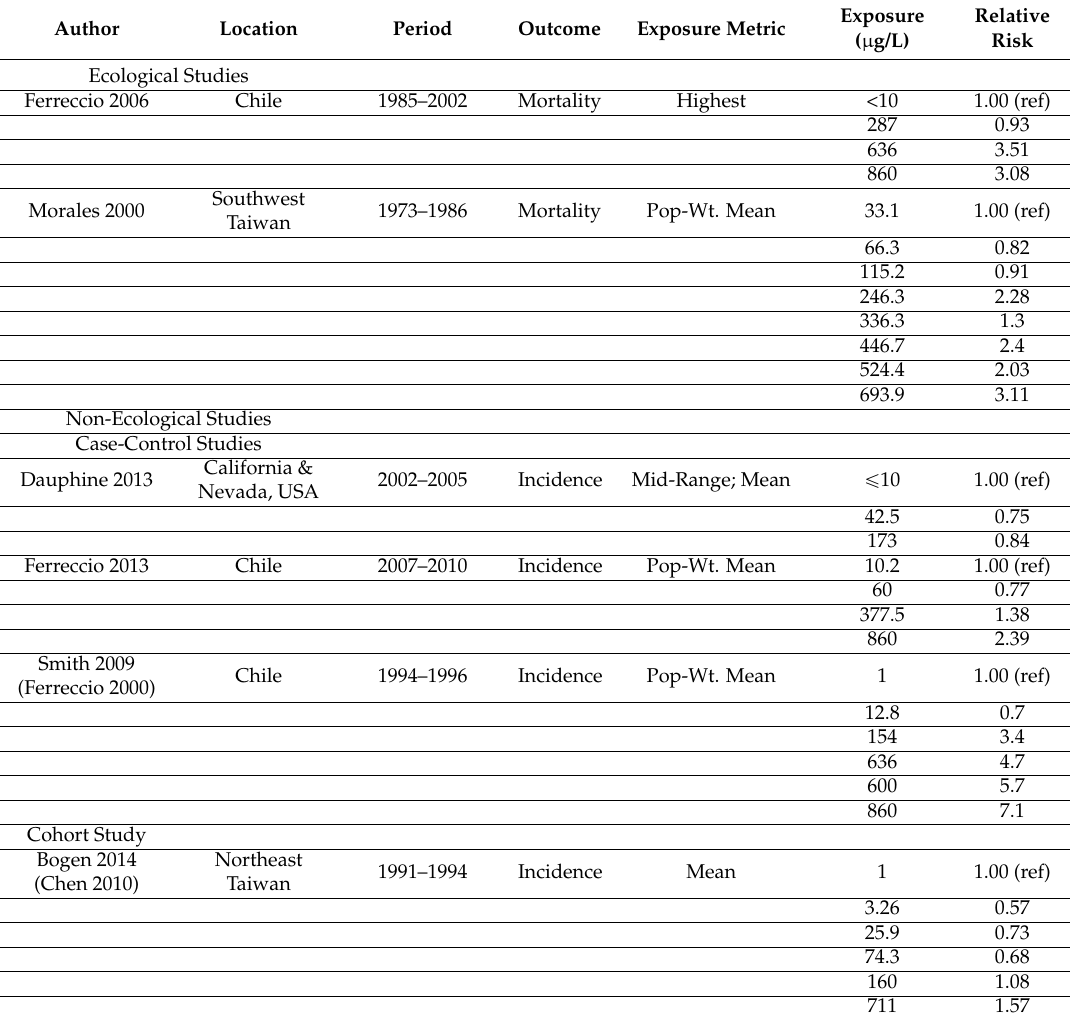
Table 1. Studies with characteristics and